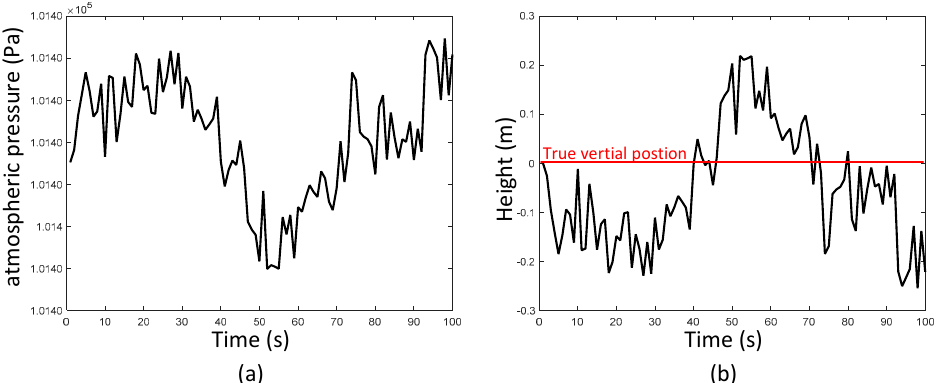
Figure 17. The atmospheric pressure fluctuates when the pedestrian walks on the same height; ( a ) is the atmospheric pressure; ( b ) is the height estimation error caused by atmospheric pressure fluctuation. The red line in ( b ) is the true vertical position (0 m).